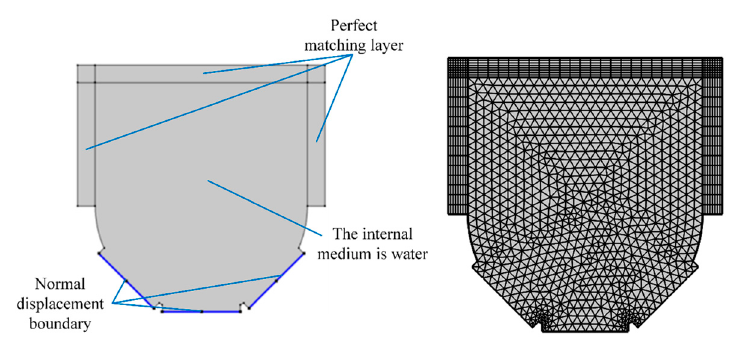
Figure 2. Physical model of simulation. Table 1. Main parameters of simulation.